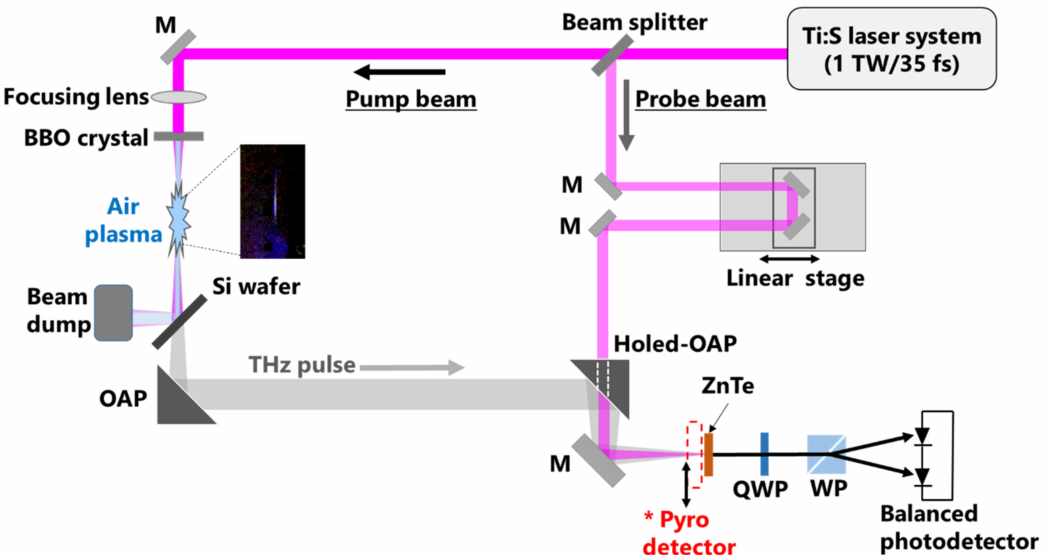
Figure 7. Schematic diagram of the experimental setup for THz wave generation using the two-color filamentation method and the THz-TDS (time-domain spectroscopy) diagnostics system. The pump beam is focused in the air to produce a strong THz pulse and the probe beam is sent to the THz-TDS system for diagnostics of the THz pulse. OAP: off-axis parabolic mirror, QWP: quarter-wave plate, WP: Wollaston prism, M: mirror. (* indicates